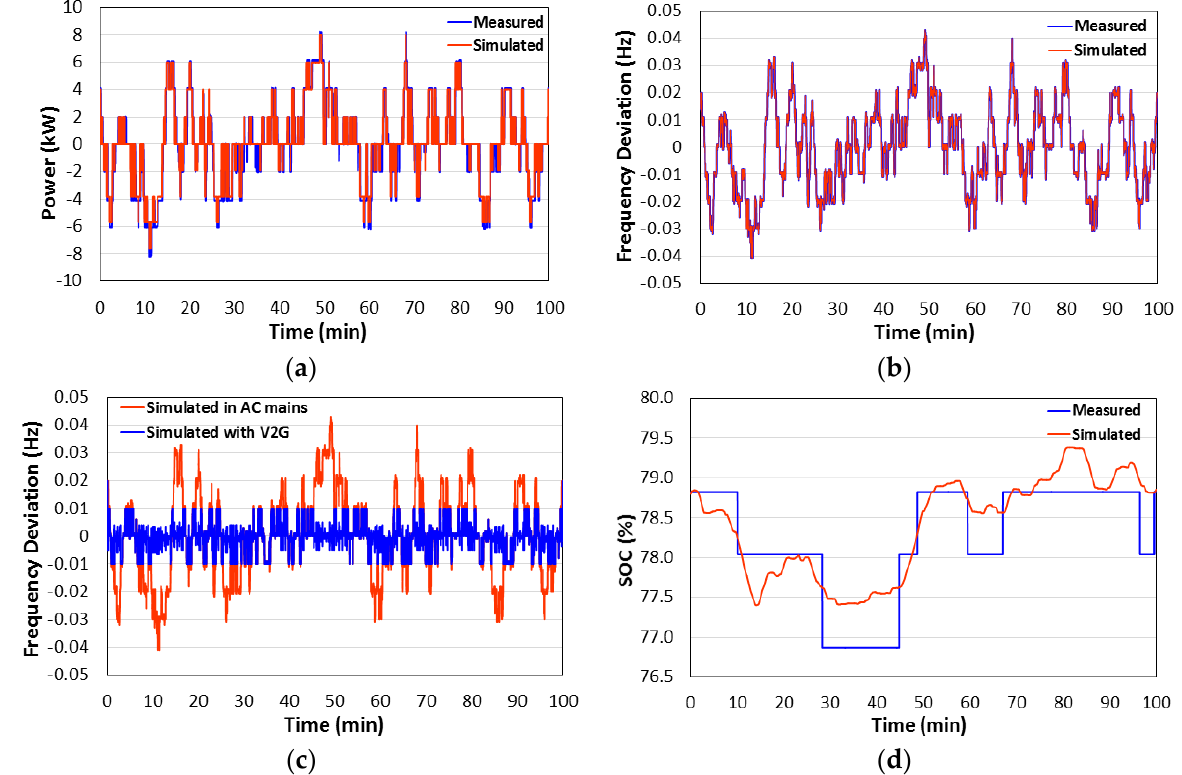
Figure 13. Comparison of ( a ) AC output from DCFC/EV (positive: charging, negative: discharging), ( b ) frequency deviation without V2G or ( c ) with V2G, and ( d ) state of charge (SOC) variation obtained from empirical testing and simulation on the single-vehicle-based PFC for 100 min (starting SOC: 78.8%).